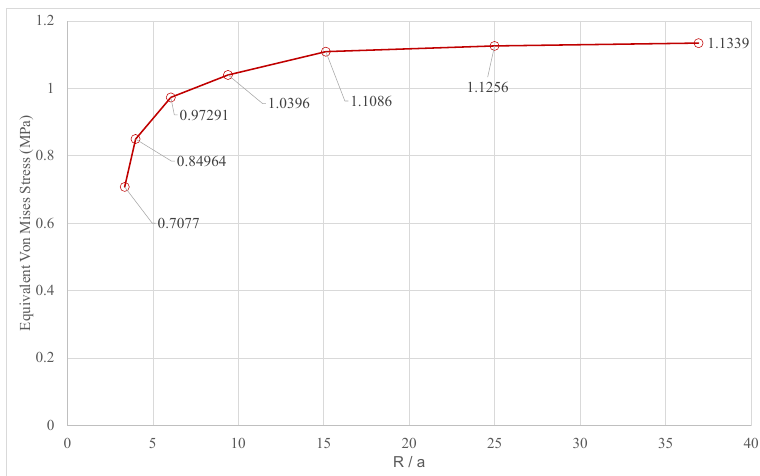
Figure 7. Convergence of the Von Mises stress versus the mesh density ratio.